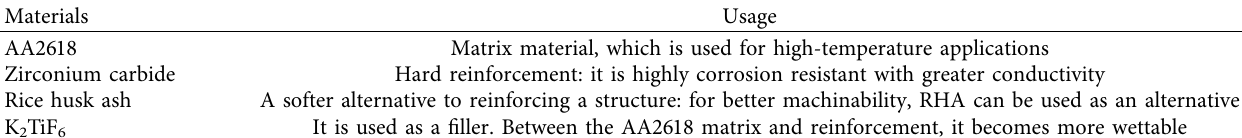
Table 1: Purpose of different materials and their usage.